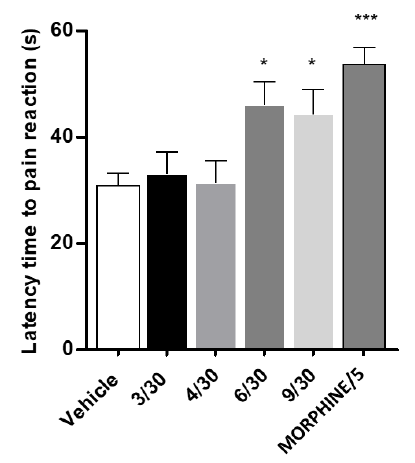
Figure 4. Effects of compounds 3 , 4 , 6 , 9 at the dose of 30 mg/kg, ip, and morphine (5 mg/kg) on Figure 4. E ff ects of compounds 3 , 4 , 6 , 9 at the dose of 30 mg / kg, ip, and morphine (5 mg / kg) on